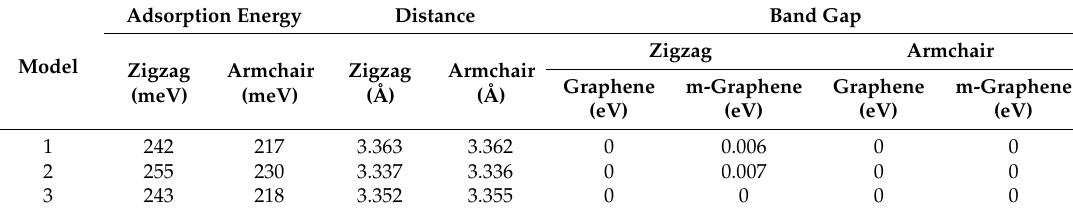
Figure 1. Three different methane adsorption models in monolayer graphene. Table 2. The adsorption energy, the distance, and the band gap of models 1, 2, and 3, respectively.